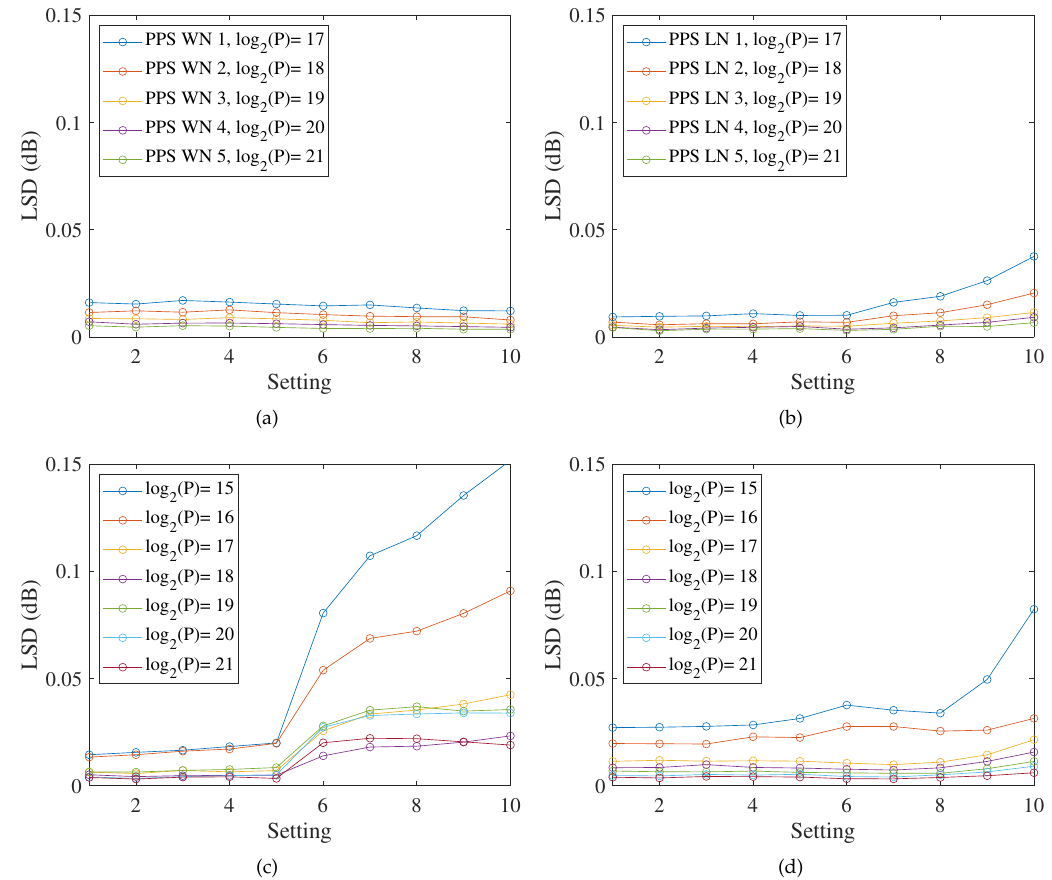
Figure 5. Log-spectral distance in the band [ 100,18,000 ] Hz at the different settings with equalization of the equipment for ( a ) PPSs for WN filters, ( b ) PPSs for LN filters, ( c ) MLSs, ( d ) exponential